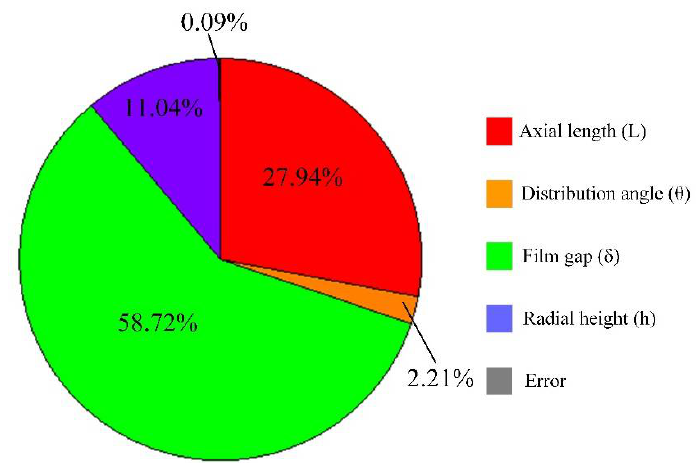
Figure 11. Contribution of structural parameters on stiffness.